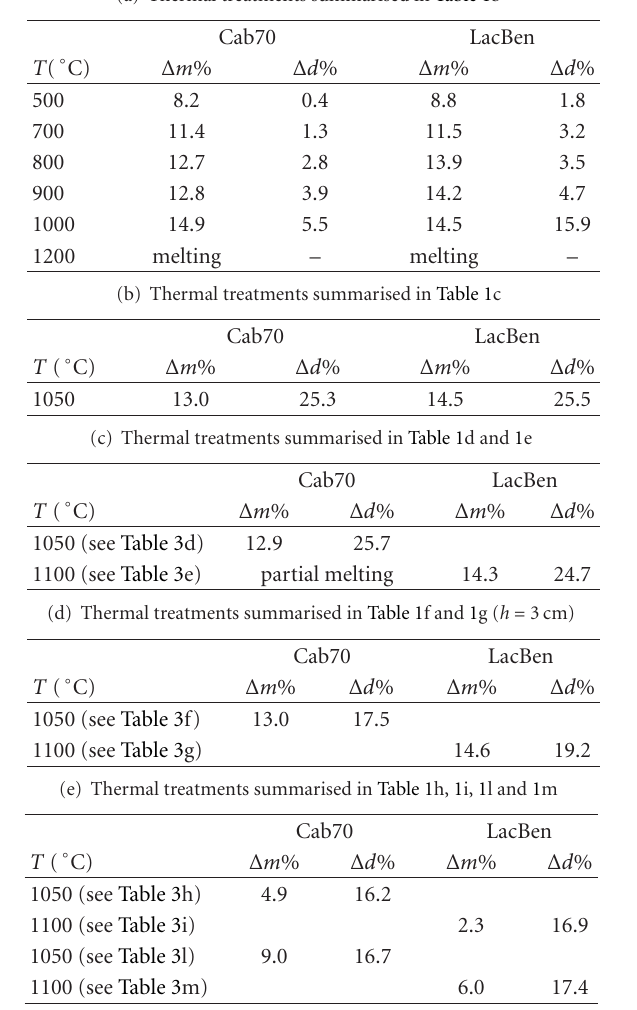
Table 4: Weight loss ( Δ m %) and linear shrinkage ( Δ d %) of compacts arising from various thermal treatments.